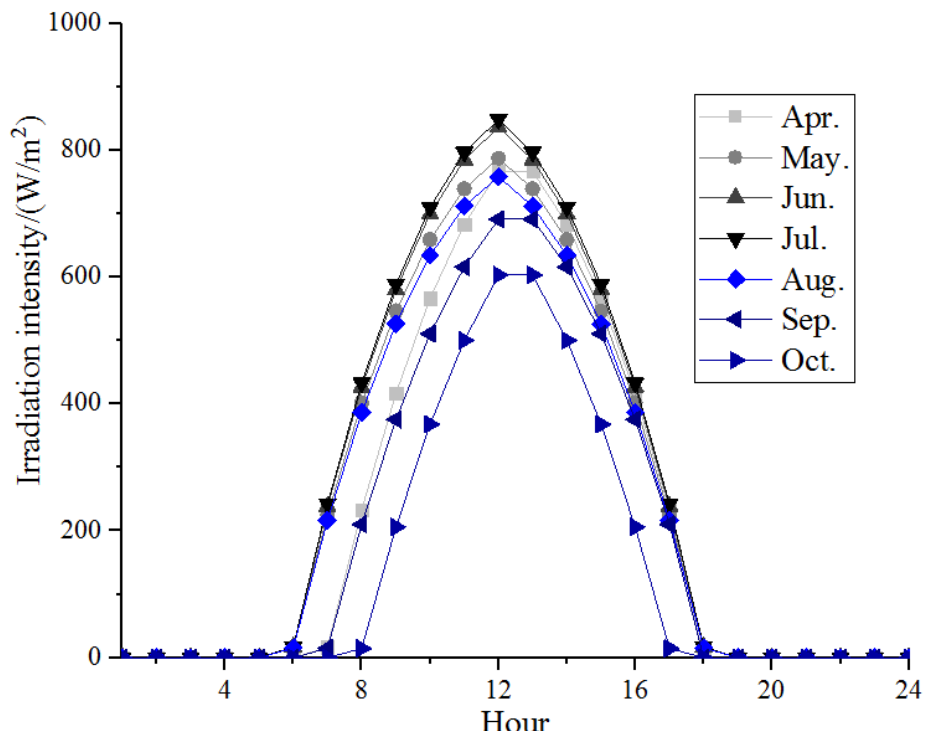
Figure 3. Daily irradiation intensity hour by hour in the heating season.